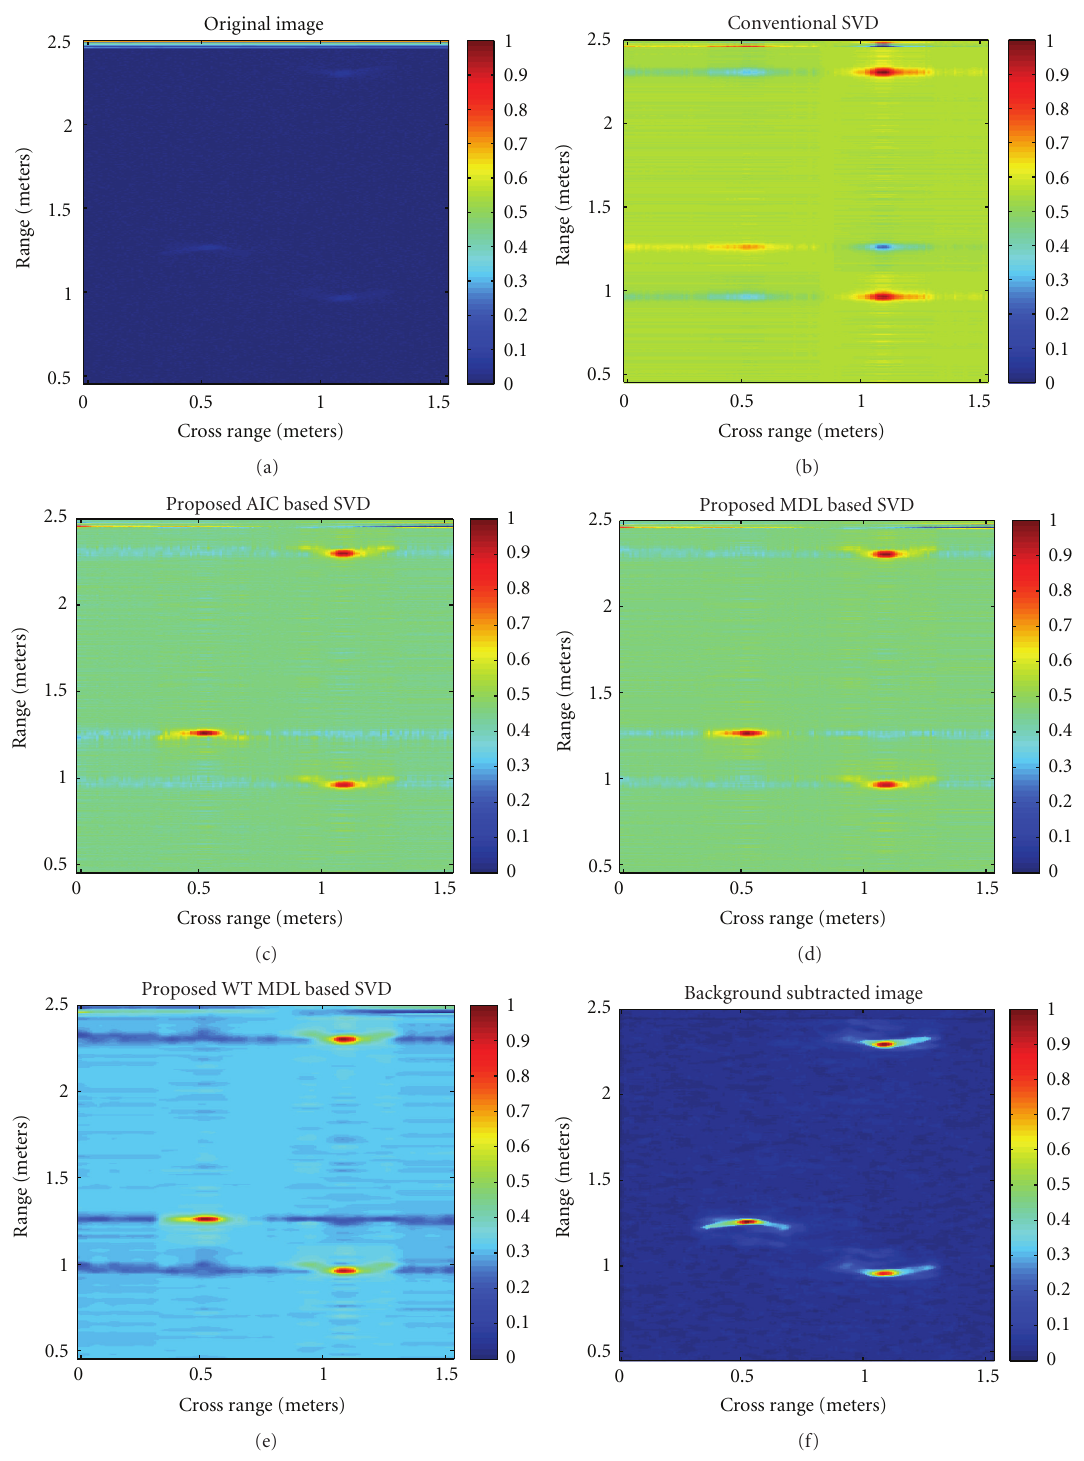
Figure 12: Example 2: Multiple (three) targets (a) original image, (b) conventional SVD, (c) AIC-based SVD, (d) MDL-based SVD, (e) WT MDL-based SVD, and (f) background subtracted